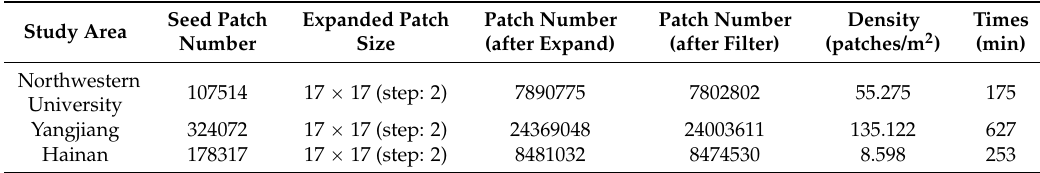
Table 4. Performance of dense point cloud generated by the proposed method.